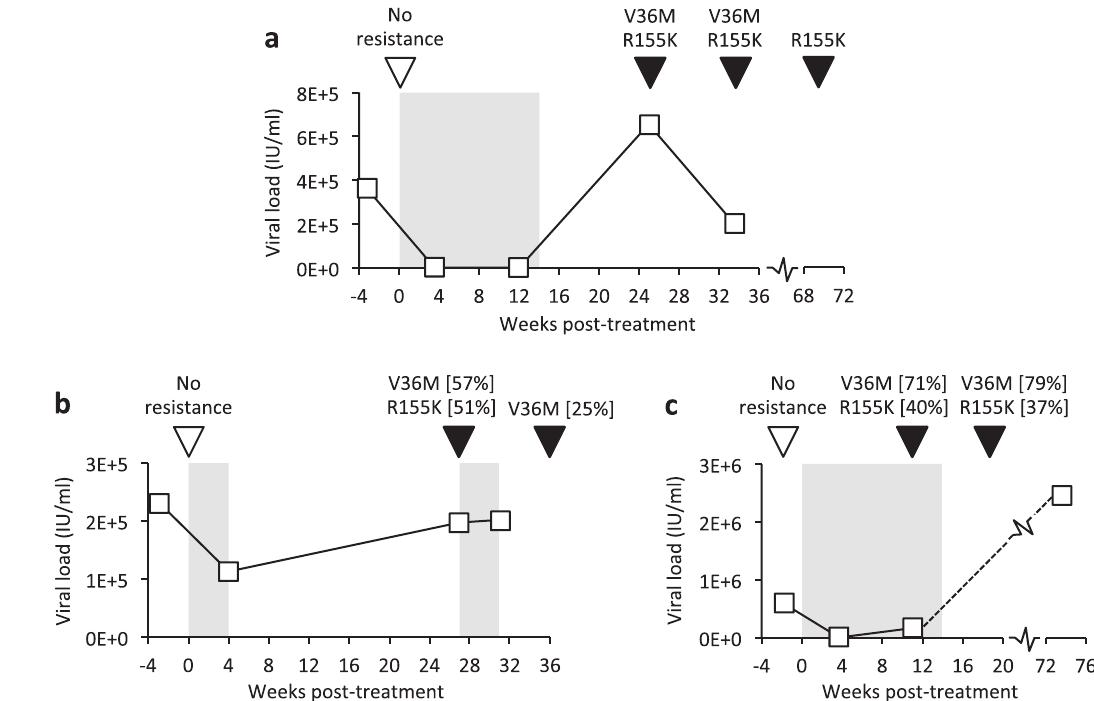
Figure 4. Detection of resistance-associated variants after DAA treatment failure. VL and RAV status for three patients who failed to achieve sustained virological response after Telaprevir-based therapy. Grey shading: duration of therapy (weeks starting at time 0); squares: VL measurements; inverted triangles: samples sequenced using the comprehensive probe panel (open: no Telaprevir RAVs detected, black: RAVs and supporting read proportions, where